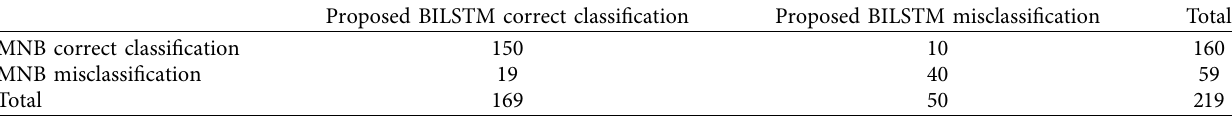
Table 10: F-G emotion class significance.